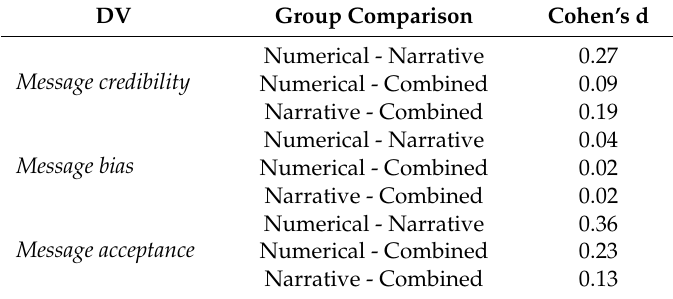
Table 4. E ff ect size by dependent variable and group